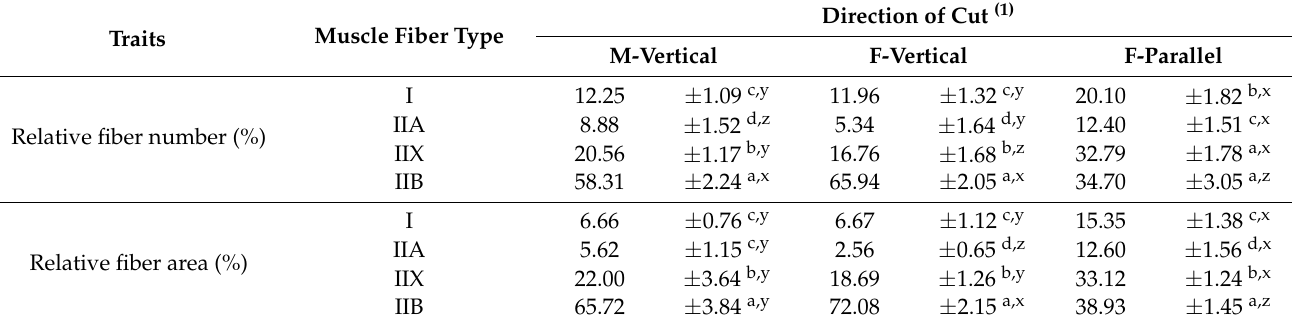
Table 1. Comparison of muscle fiber composition between pork loin chops cut in different directions.